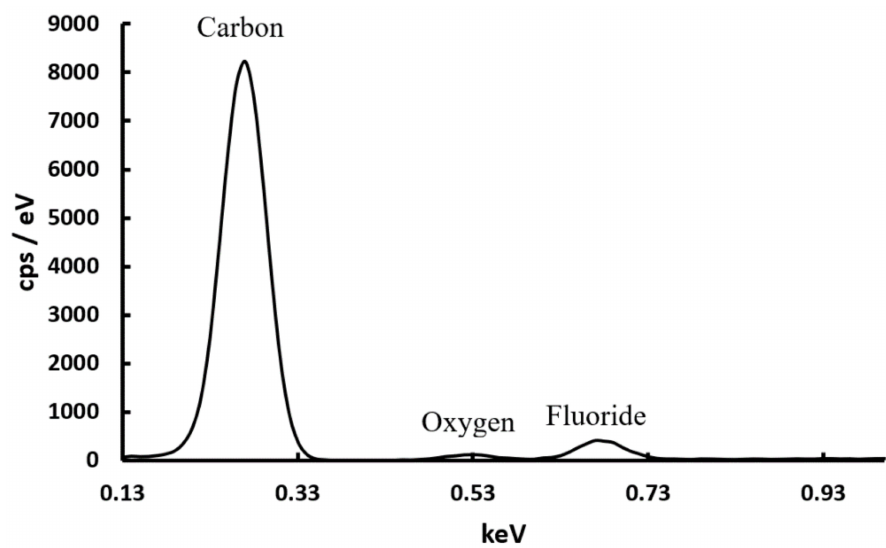
Figure 4. Energy dispersive x-ray spectroscopy (EDS) of Activated Carbon (AC) + Carbon Black (CB) + Polyvinylidene Difluoride (PVDF) 30 min wet mixture with N , N -dimethylacetamide (DMAC) as solvent and dried at 130 ◦ C for 12 h.